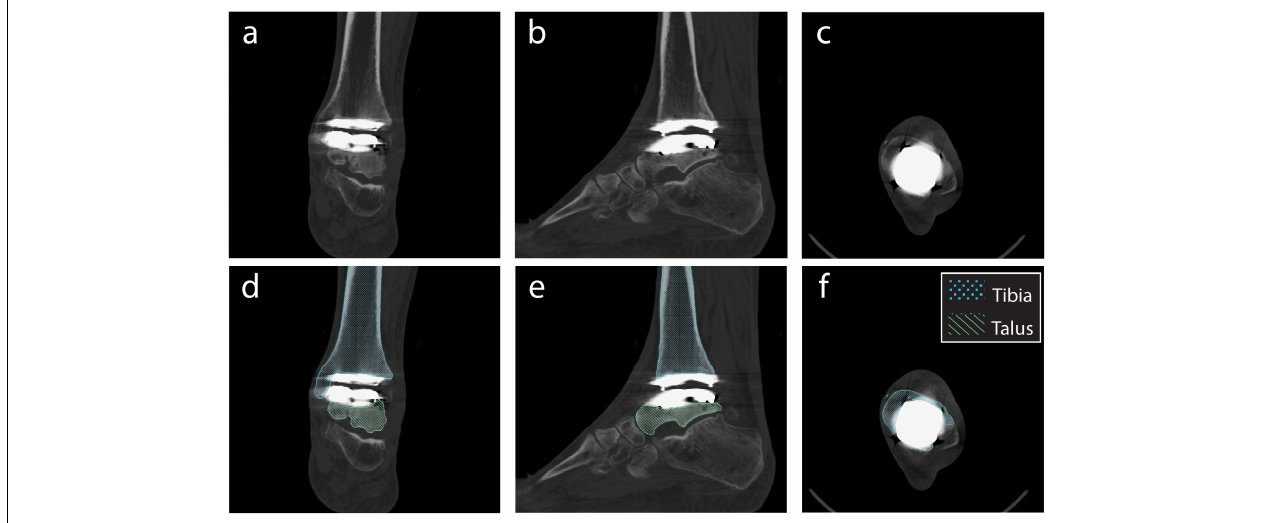
FIGURE 3 | Planar CT image slices using the metal artifact reduction algorithm (Siemens iMAR R (cid:13) ). Planar views demonstrated in: (a,d) Coronal, (b,e) Sagittal, and (c,f) Transverse planes. Segmentation shown for the tibia and talus (d–f) .